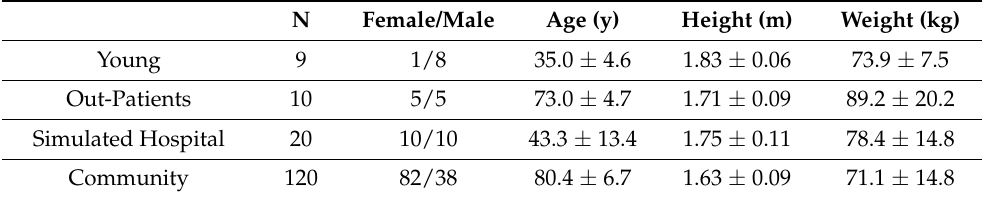
Table 1. Demographics of the included studies. Age, height, and weight are presented as mean ±